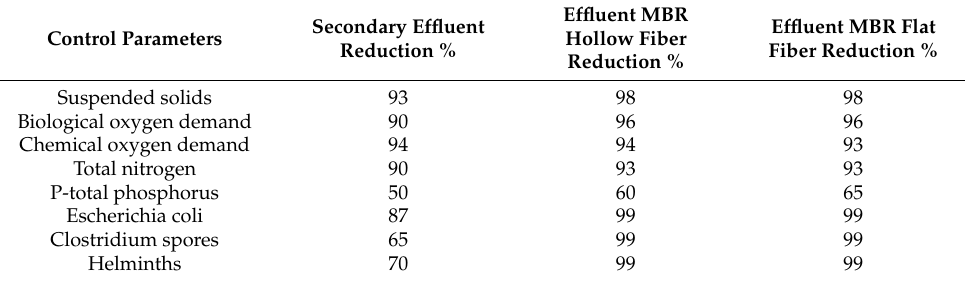
Table 4. Average pollutant removal efficiencies with different treatment technologies.